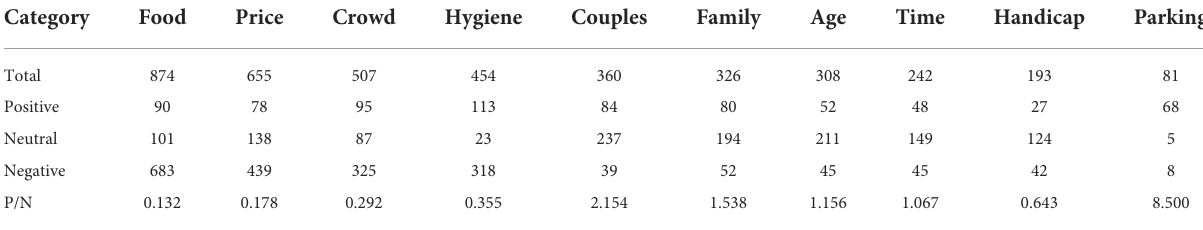
TABLE 2 Sentiment analysis